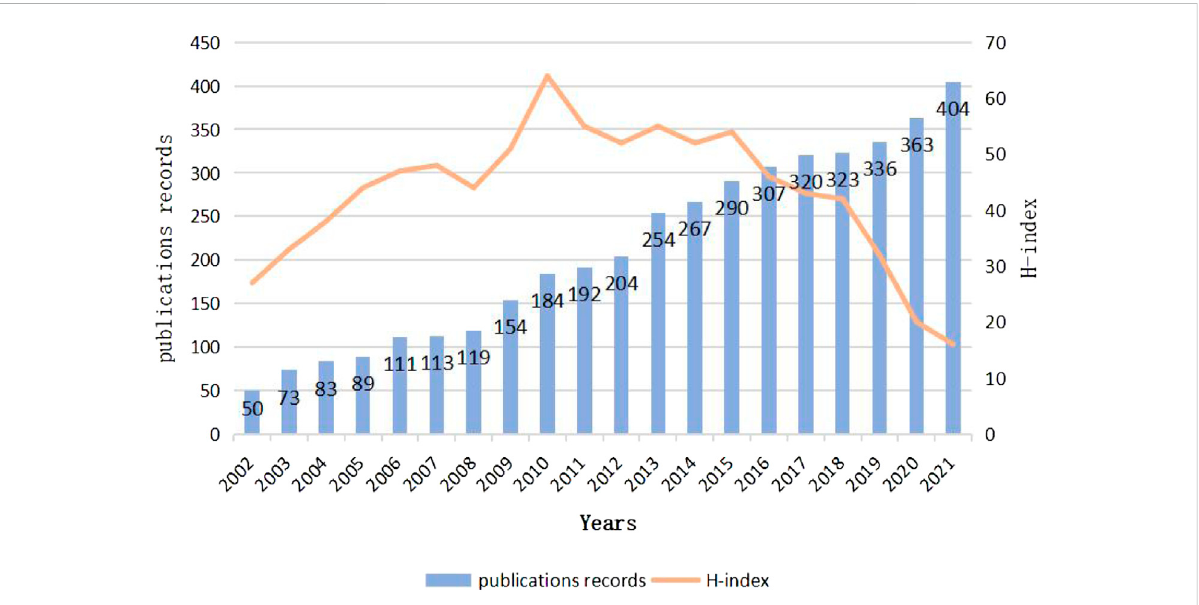
FIGURE 2 Global number of publications and H-index of publications in the fi eld of relationship between Mitochondrial function and heart failure from 2002 to 2022.